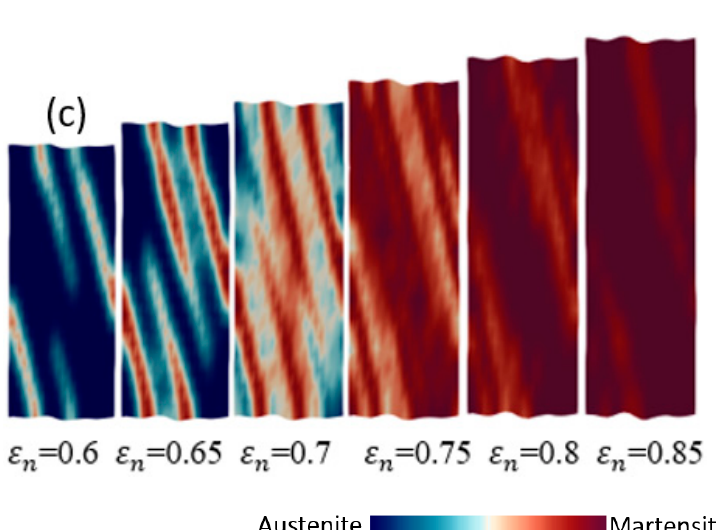
Figure 17. The distribution of the martensitic phase of single crystal TRIP steel with different mesh sizes ( a ) coarse mesh, ( b ) intermediate mesh, and ( c ) fine mesh.